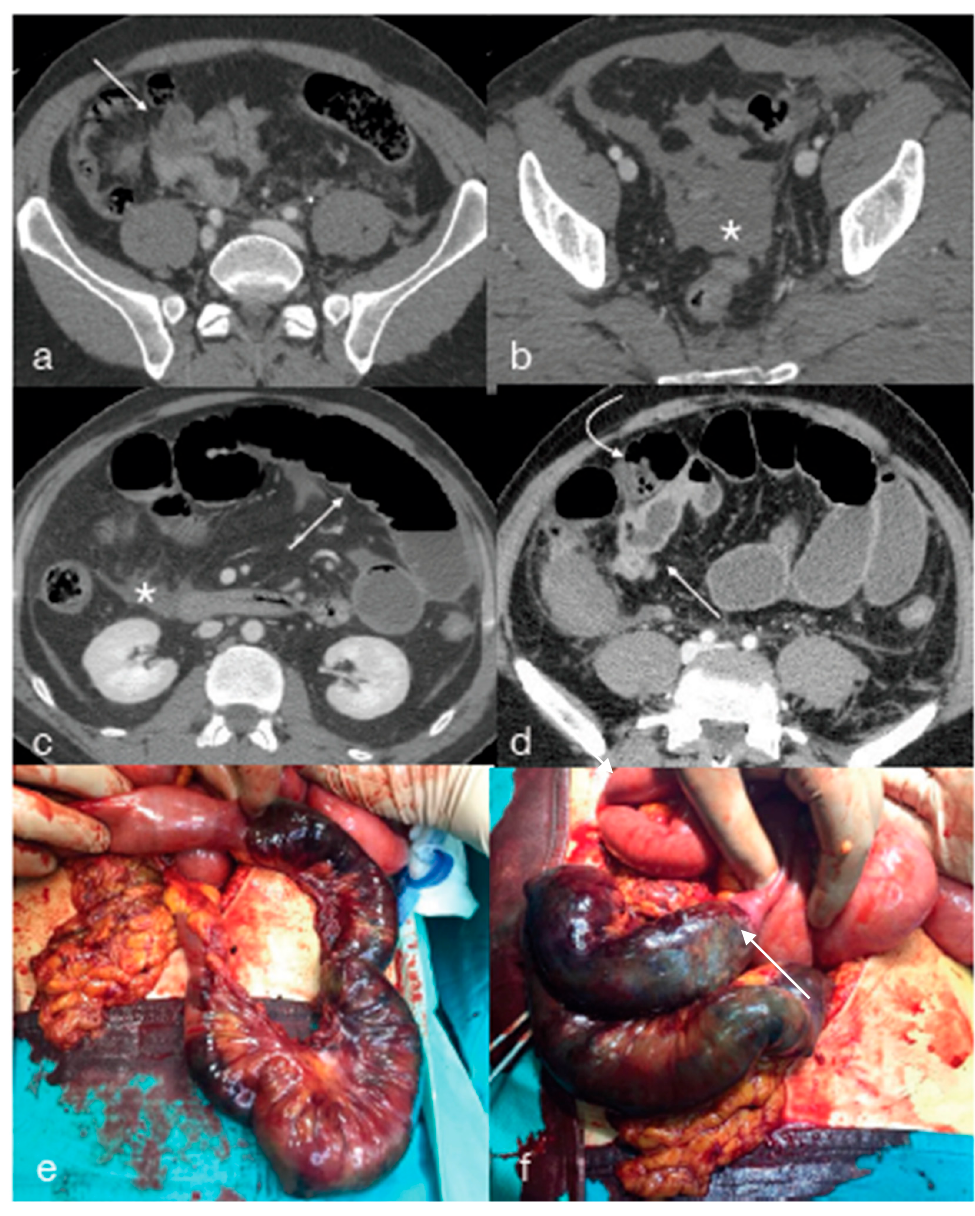
Figure 3. A twenty-eight-year-old male patient underwent high-energy blunt trauma. The enhanced CT performed upon admission, portal phase axial view, showed mesenteric fat stranding (( a ) arrow) and free fluid in the pelvis (( b ) asterisk). A few hours later, the patient developed intense abdominal pain and abdominal tension, and the enhanced CT examination was repeated (( c , d ) portal phase, axial plane), showing free peritoneal fluid (( c ) asterisk), bowel distension with air–fluid level (( c ), arrow) proximal to an ileal tract with inhomogeneous enhancement of the wall, partly with “paper thin” appearance due to arterial ischemia (( d ) curved arrow) and partly thickened and hyperdense (( d ) straight arrow) due to ischemic–reperfusion changes. These fi ndings were indicative of a mesenteric-bowel injury, so the patient underwent emergent surgery, con fi rming a mesenteric laceration, ( e ) causing intestinal ischemic–necrotic changes ( f , arrows).